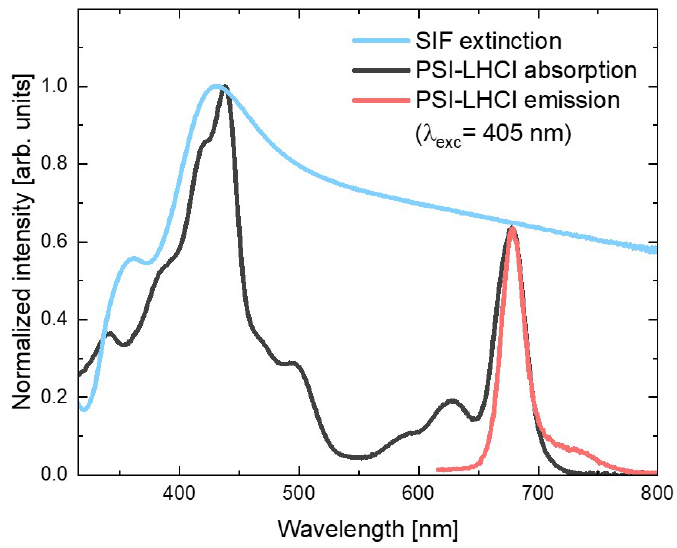
Figure 1. Absorption and emission spectra of PSI–LHCI (black and red, respectively) and extinction spectrum of SIF (blue).